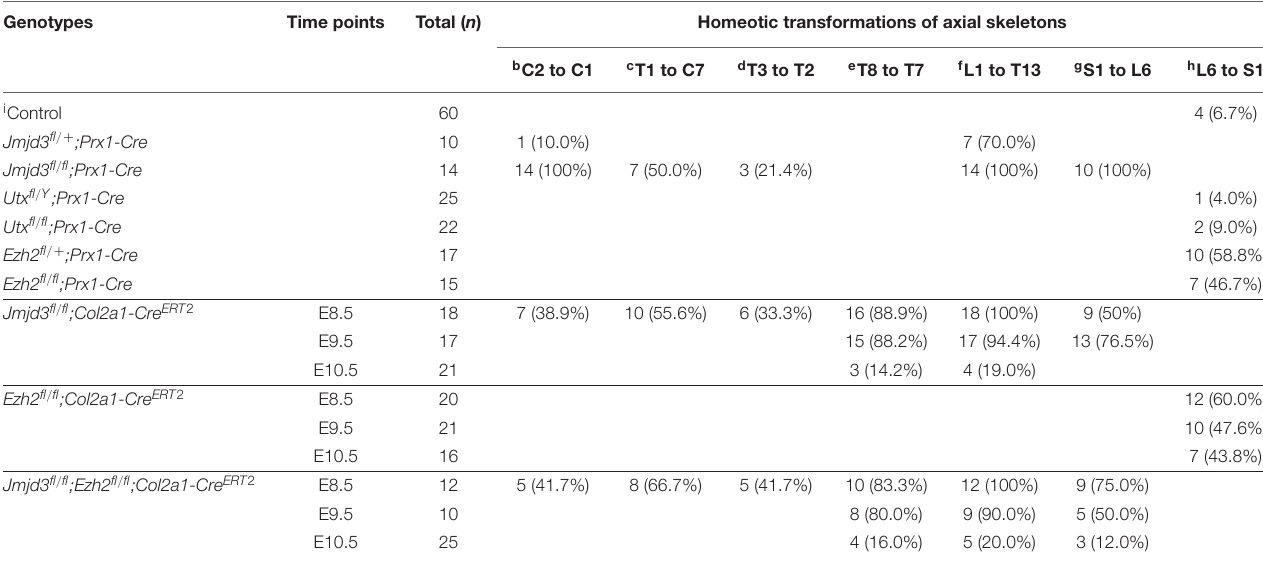
TABLE 1 | a Homeotic transformations of axial skeletons with various